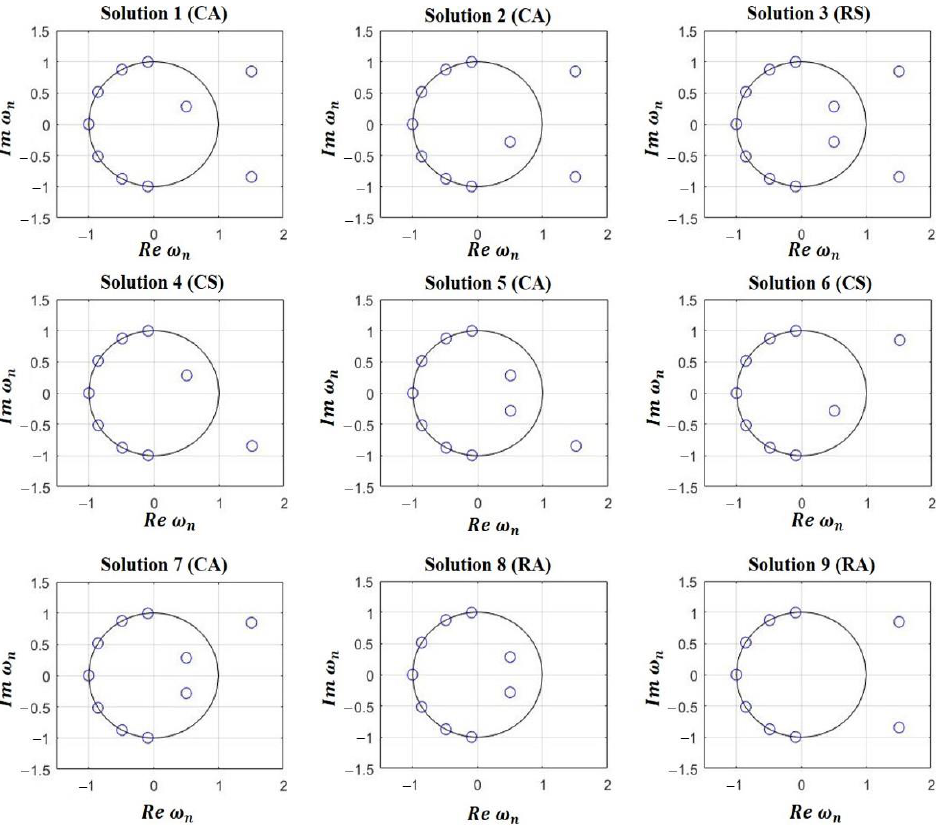
Figure 1. The nine possibilities about root positions corresponding to a 12-element linear array (sketched in Figure 3) designed to produce flat-top beam with two filled nulls ( M = 1), a ripple of ± 0.5 dB and a sidelobe level of − 20 dB. In terms of nature: Solution 3 is real symmetric (RS), Solutions 8 and 9 are real asymmetric (RA), Solutions 4 and 6 are complex symmetric (CS), and Solutions 1 , 2 , 5 , and 7 are complex asymmetric (CA).